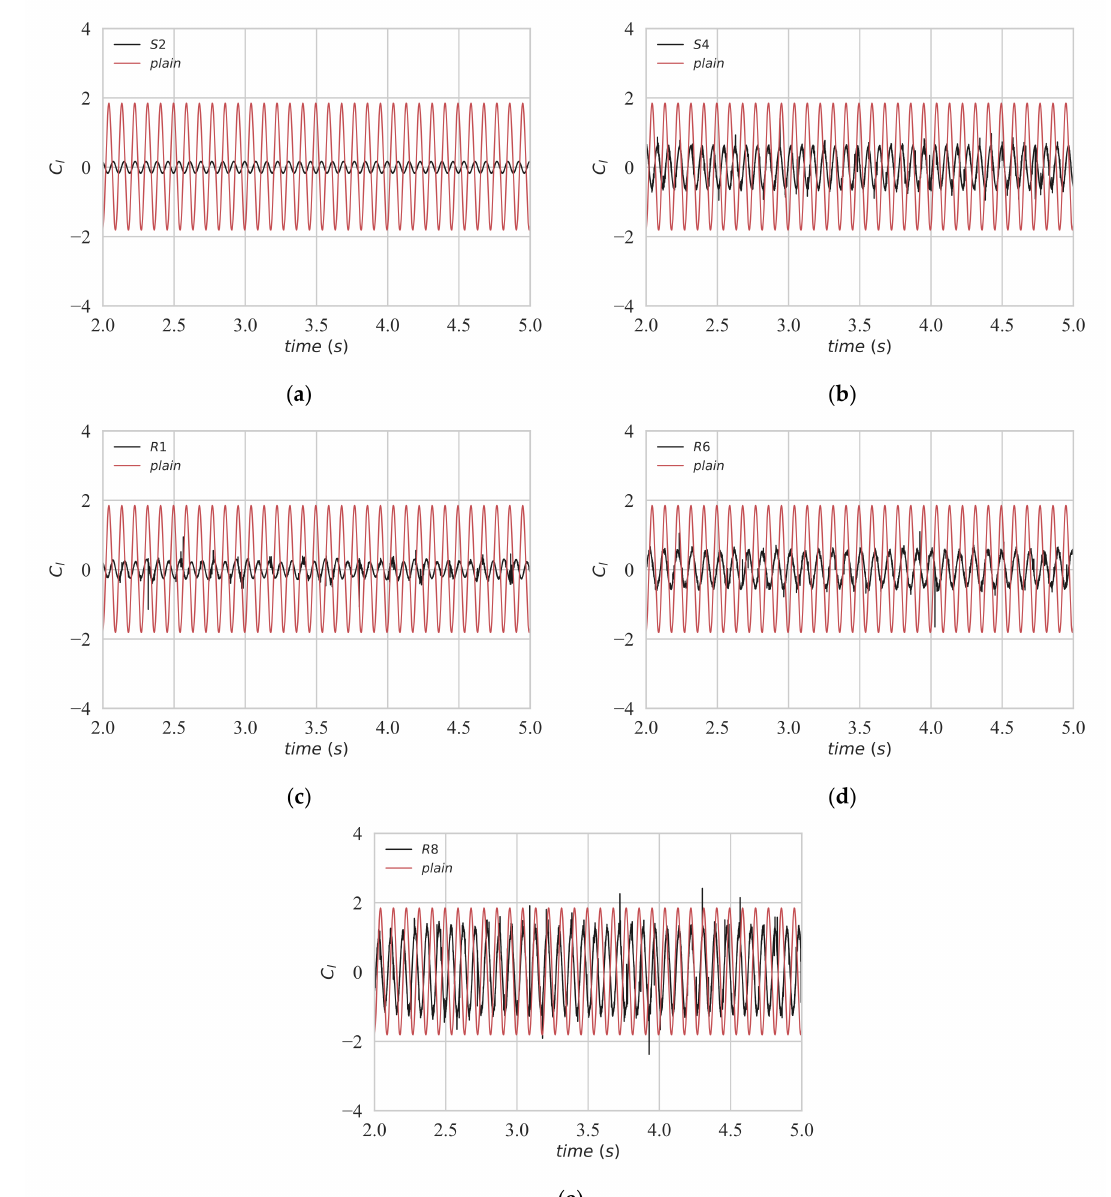
Figure 8. Comparison of time history of Cl : ( a ) S2 ; ( b ) S4 ; ( c ) R1 ; ( d ) R6 ; ( e ) R8